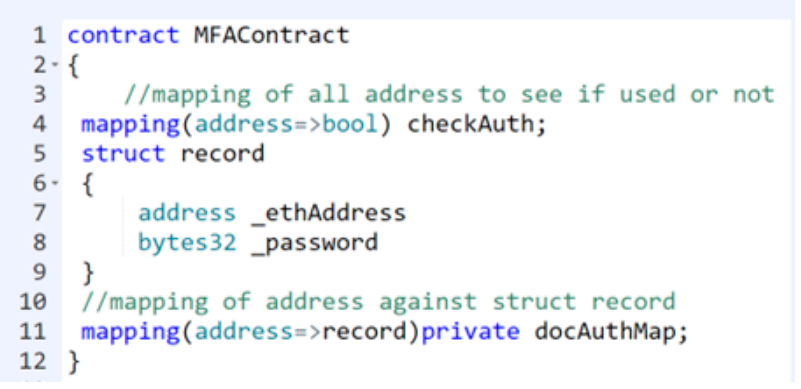
Figure 14. Code snippet of BAuth-ZKP MFA Smart Contract.